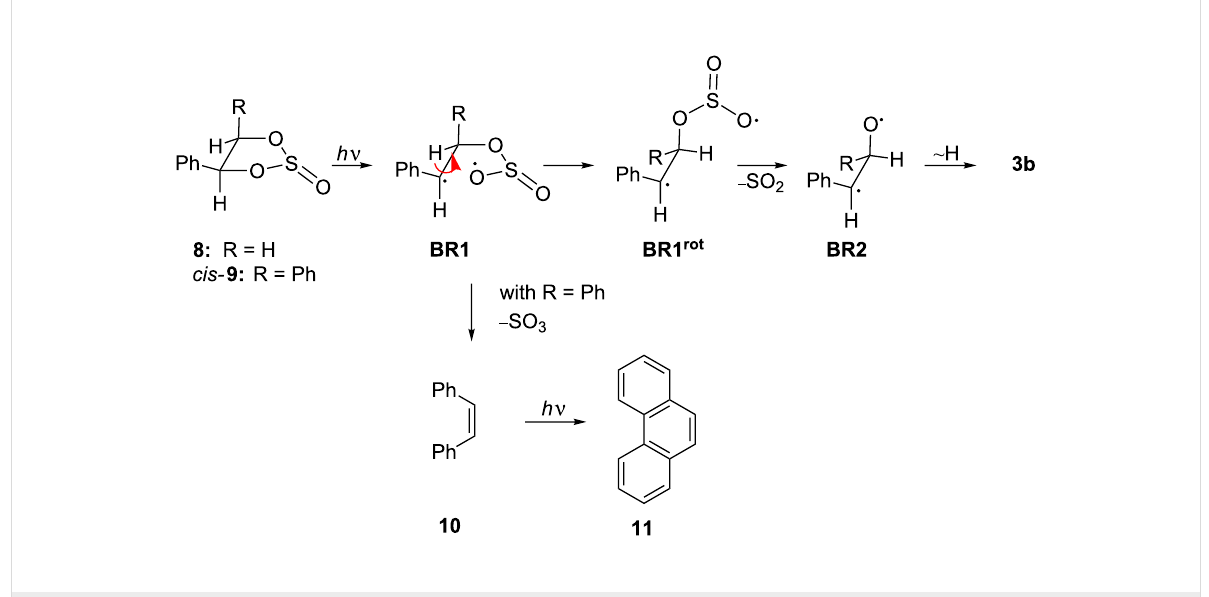
Scheme 3: Photochemical pathway for photoextrusion of SO 2 from cyclic sulfites.